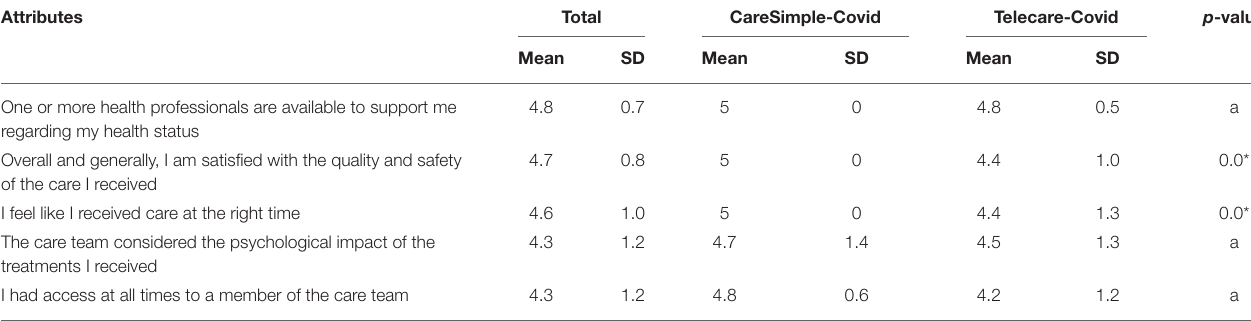
TABLE 4 | Mean and SD relative to perceptions of quality and safety of care (overall and for each platform